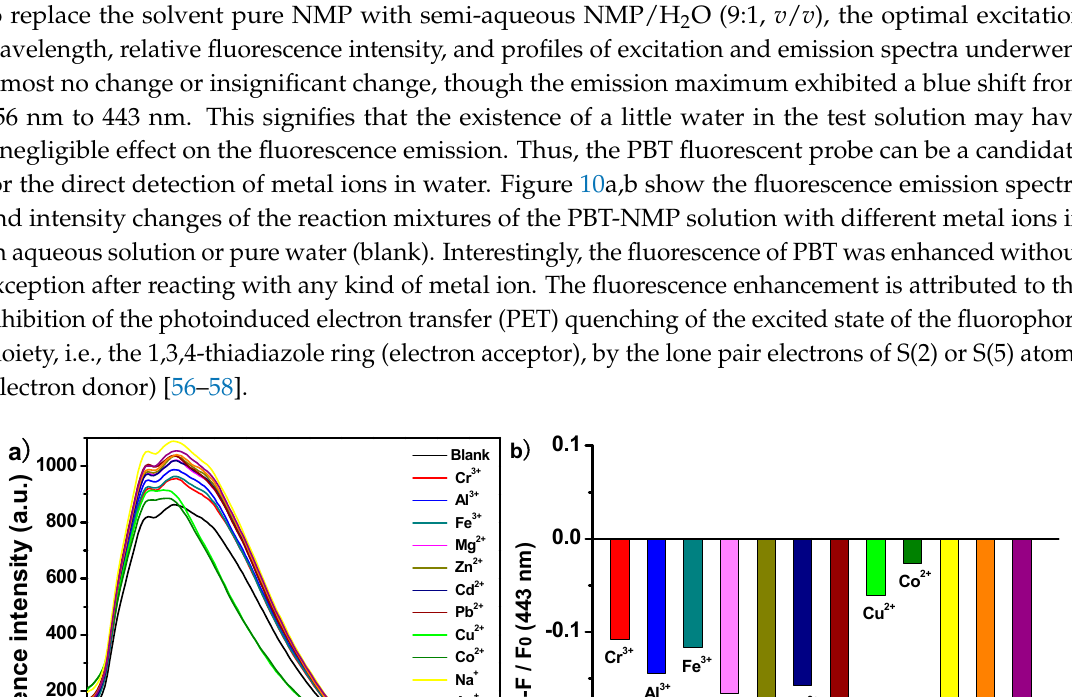
Figure 9. Fluorescent excitation and emission spectra obtained at fixed slit widths of 5 nm of 100 μ g L − 1 BT and PBT solutions in N -methy1-2-pyrrolidone (NMP).